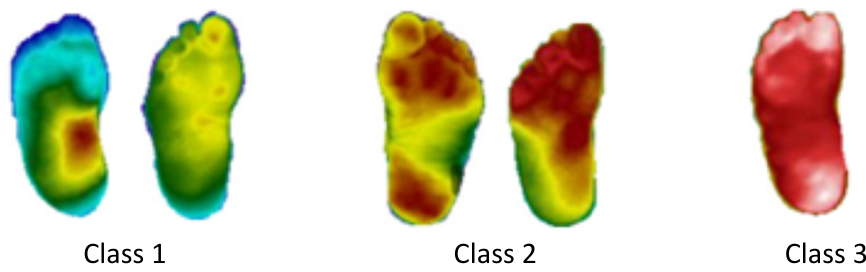
Figure 4. Reclassification of thermograms of diabetics in 3 classes. Figure 3 . Reclassification of thermograms of diabetics in 3 classes.